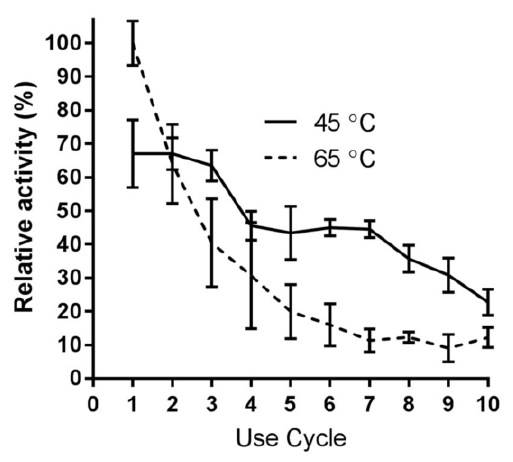
Figure 6. Mean relative activity of immobilized Endo BI-1 on RNase B following several reuse cycles. Error bars represent one standard deviation.